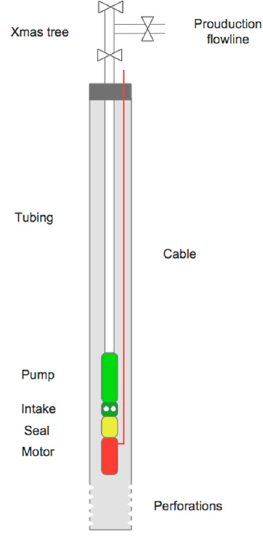
Figure 2. Electrical submersible pumps (ESP) system configuration.